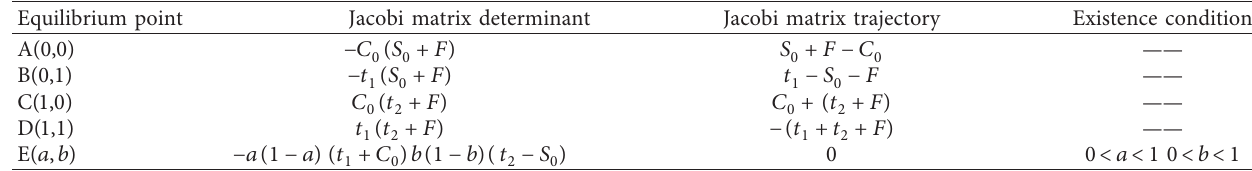
Table 6: Local stability of social capital’s cooperation degree in public rental housing PPP projects.